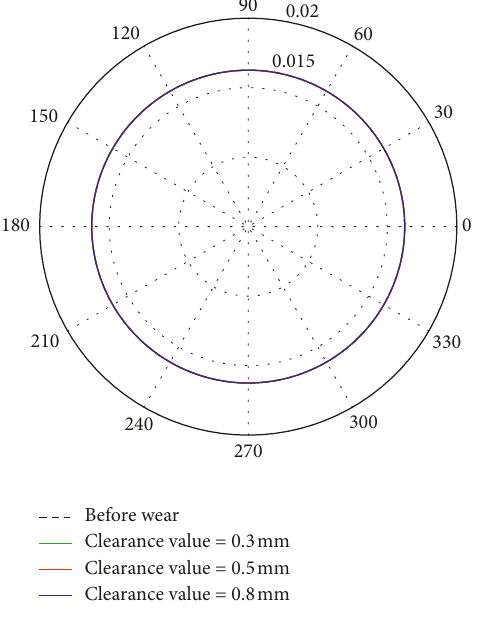
Figure 31: Bearing surface of joint A .